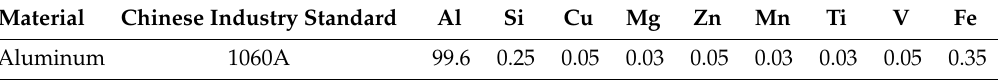
Table 2. Chemical compositions of specimen (%).